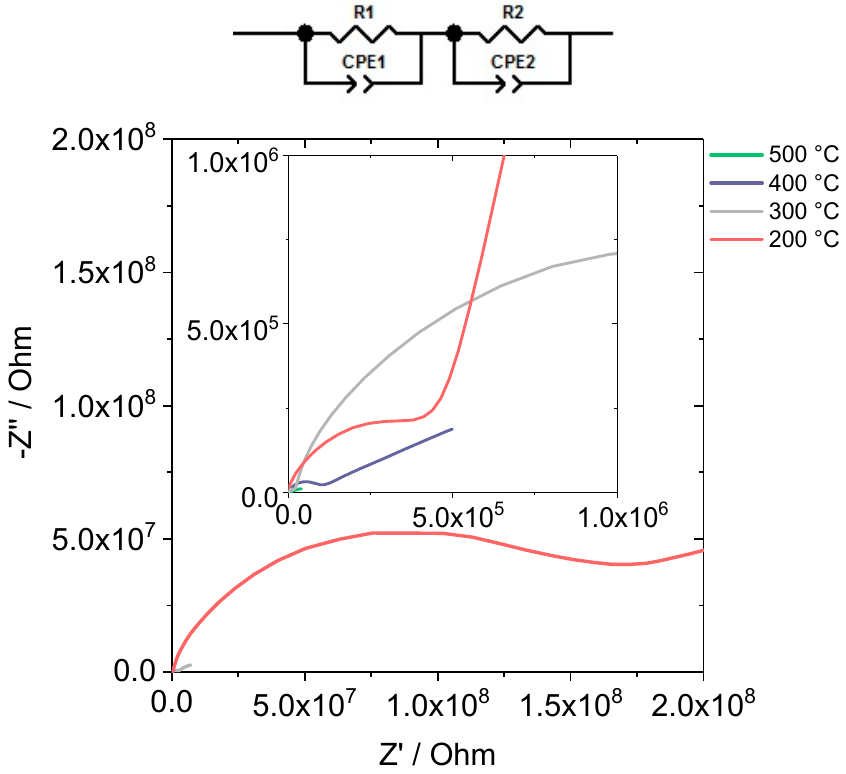
Figure 1 . Exemplary impedance spectra for pure CGO at 200 − 500 °C. Higher temperatures are shown in the inlay. The equivalent circuit used for data evaluation is shown above the graph.